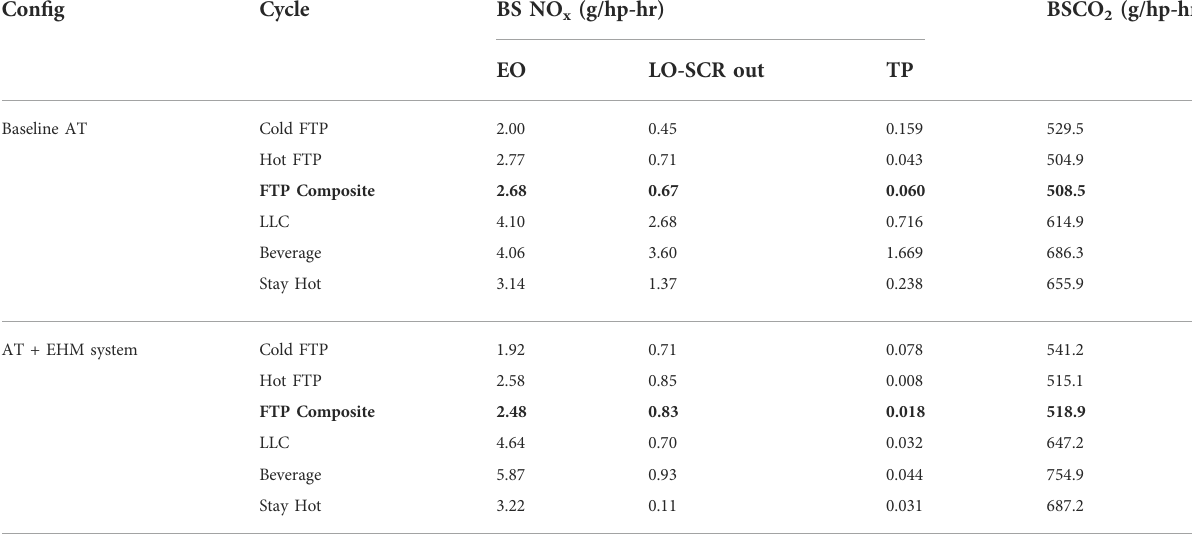
TABLE 12 Test results summary of drive cycles.